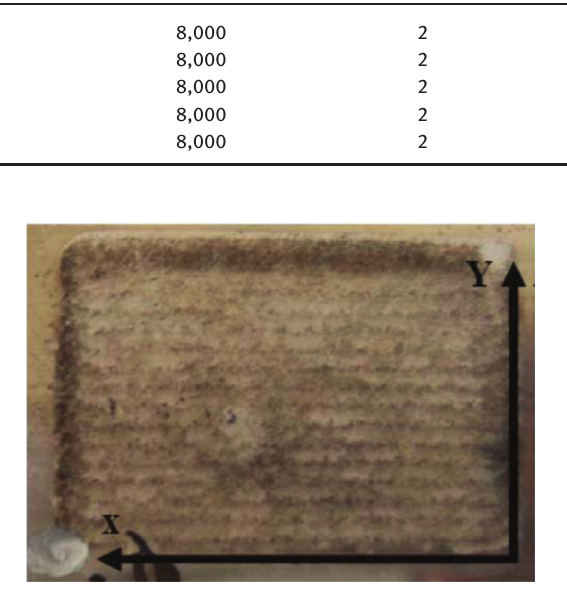
Figure 3: In situ scanogram spot of the steel